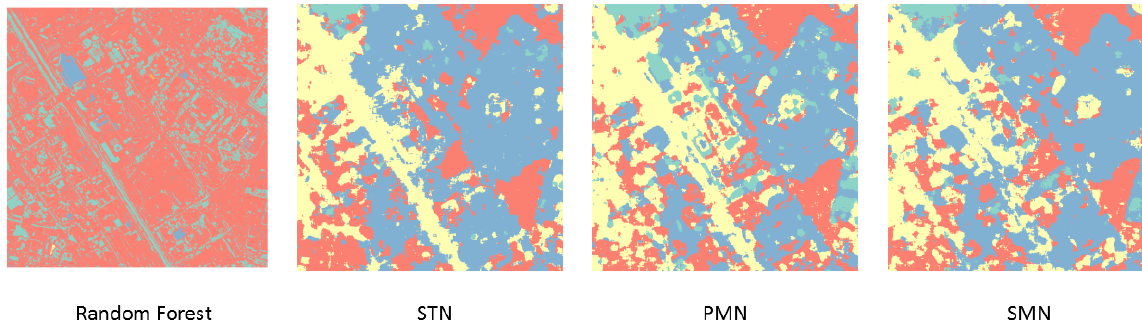
Figure 3. Predicted land use maps of the four classifiers on test Tile 1.